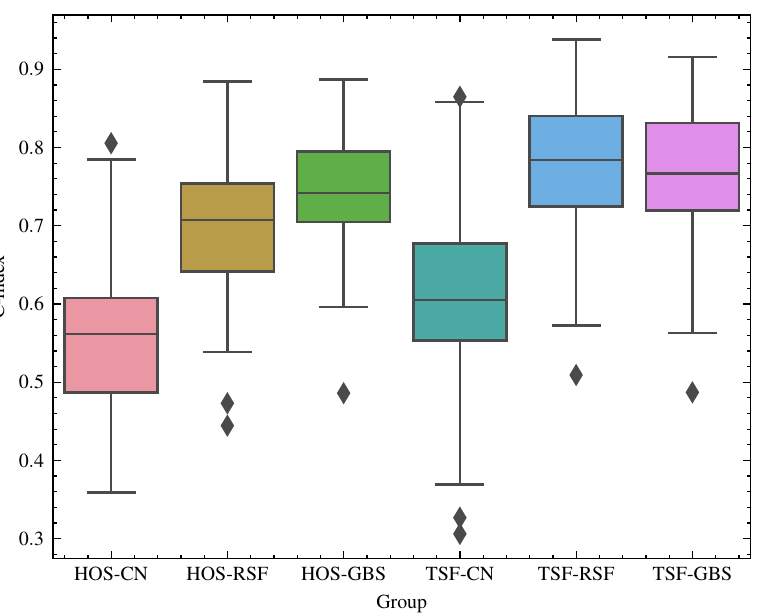
Figure 5. Box plot representation of the C-index scores by group of feature strategies and survival models for the 100 simulations performed. The groups with the highest accuracy were TSF-RSF and TSF-GBS, while the lowest was